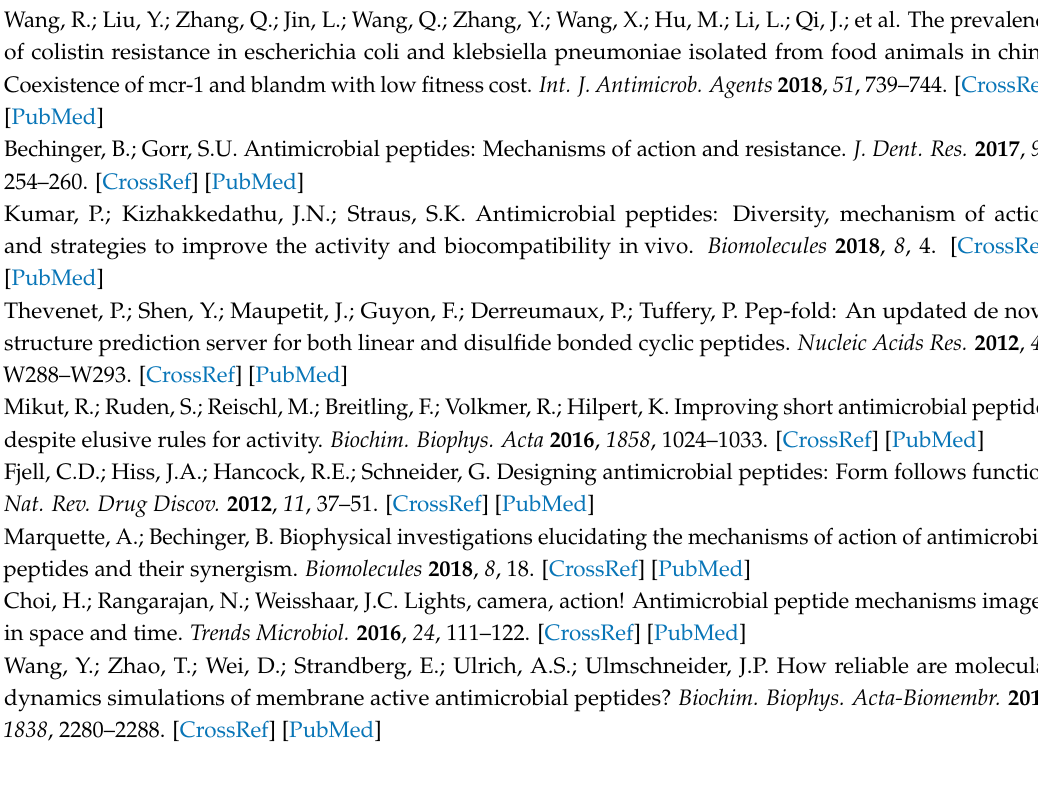
Table S2: Set of short sequence antimicrobial peptides, showing their size, sequence, net charge at pH 7.4 and minimum inhibitory concentration (MIC) against some of the most common Gram-negative strains, Figure S1: The experimentally-derived conformations of the PDB entries the centroids of the less populated clusters resulting from hierarchical clustering (HC) of 117 antimicrobial peptides with experimentally-known conformations, Figure S2: Backbone superposition of PDB entry 2F3A (red), with simulated conformations at 0, 1.2 and 10 ns (blue). The conformation at 1.2 ns is very similar to the PDB entry and it progressively modifies during the simulation., Figure S3: Backbone superposition of PDB entry 1D7N (red) with simulated conformations at 0, 1.2 and 10 ns (blue). Superposition slightly decreases over simulation time, suggesting a flexible peptide, especially at the extremities, Figure S4: Backbone superposition of PDB entry 2JMY (red) with simulated conformations at 0, 1.2 and 10 ns (blue). RMS at 0 and 1.2 are quite similar, but similarity decreases over simulation time, suggesting flexibility, especially at the N terminus, Figure S5: Backbone superposition of PDB entry 2MAA (red) and simulated conformations at 0, 1.2 and 10 ns (blue). RMS progressively increases during simulation time, Figure S6: Backbone superposition of PDB entry 1T51 (red) and simulated conformations at 0, 1.2 and 10 ns (blue). Similarity decreases over simulation time, with a distinct flexibility observed at the C terminus, Figure S7: Backbone superposition of PDB entry 2L24 (red) and simulated conformations at 0, 1.2 and 10 ns (blue). As opposed to the peptides analyzed previously, the NMR experiments of 2L24 were acquired in the absence of micelles. However, similarly to the previous cases, similarity also decreases over simulation time, Figure S8: Backbone superposition of PDB entry 2N9A (red) and simulated conformations at 0, 1.2 and 10 ns (blue). 2N9A NMR data were obtained in a simple solution without micelles. Similarity decreases over simulation time, Figure S9: Backbone superposition of PDB entry 2NAL (red) and simulated conformations at 0, 1.2 and 10 ns (blue). NMR data were obtained in the absence of micelles and similarity decreases over simulation time, Figure S10: The conformations centroids of the less populated clusters after hierarchical clustering of the predicted structures of cationic peptides with activity against Gram negative bacteria. References [11,12,14–16,18–22,31,33,34,37,44–173] are cited in the supplementary